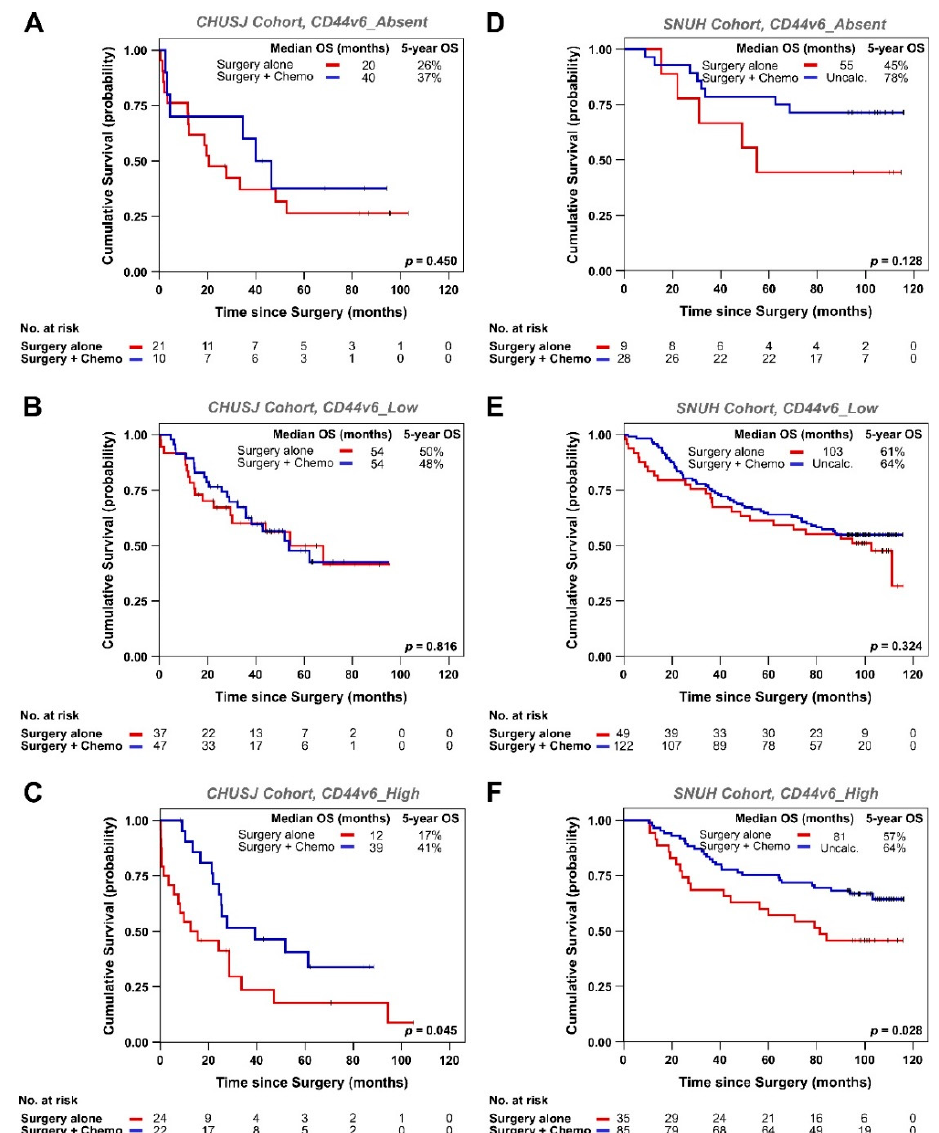
Figure 3. Kaplan–Meier estimates showing OS of GC patients treated with surgery alone (red) or surgery plus conventional chemotherapy (blue), according to CD44v6. OS of CHUSJ patients with CD44v6_Absent ( A ), CD44v6_Low ( B ), and CD44v6_High ( C ) tumors; OS of SNUH patients with CD44v6_Absent ( D ), CD44v6_Low ( E ), and CD44v6_High ( F ) tumors. The tables below each graph indicate the number of patients still at risk in each group. Only pTNM stage II and III patients are included in this analysis since >95% of stage I patients herein analyzed remained chemotherapy untreated and would bias this analysis, and stage IV patients are treated with palliative chemotherapy without curative intent. Median OS and 5-year OS are shown for each patient